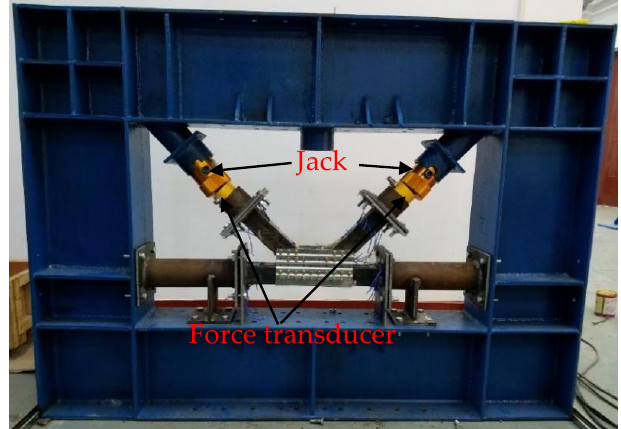
Figure 9. Testing rig of K-joint specimen.